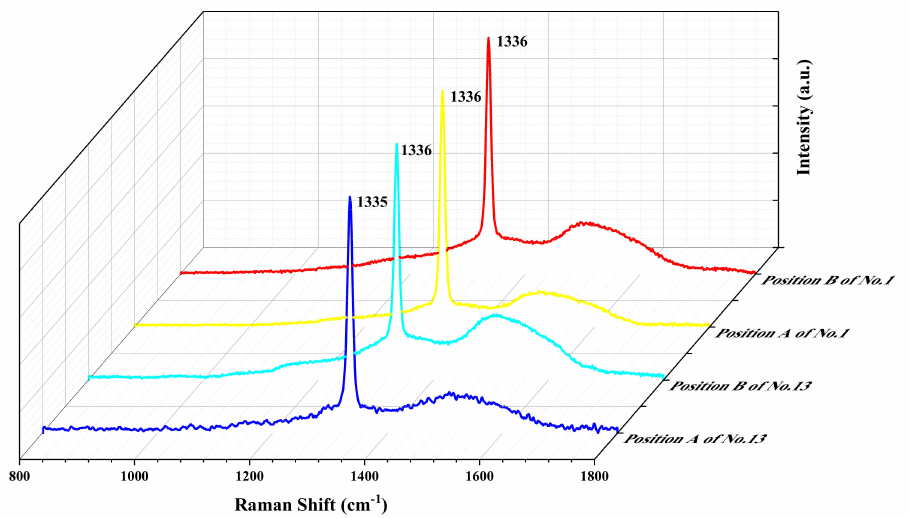
Figure 7. Raman spectra of diamond coated mills at di ff erent